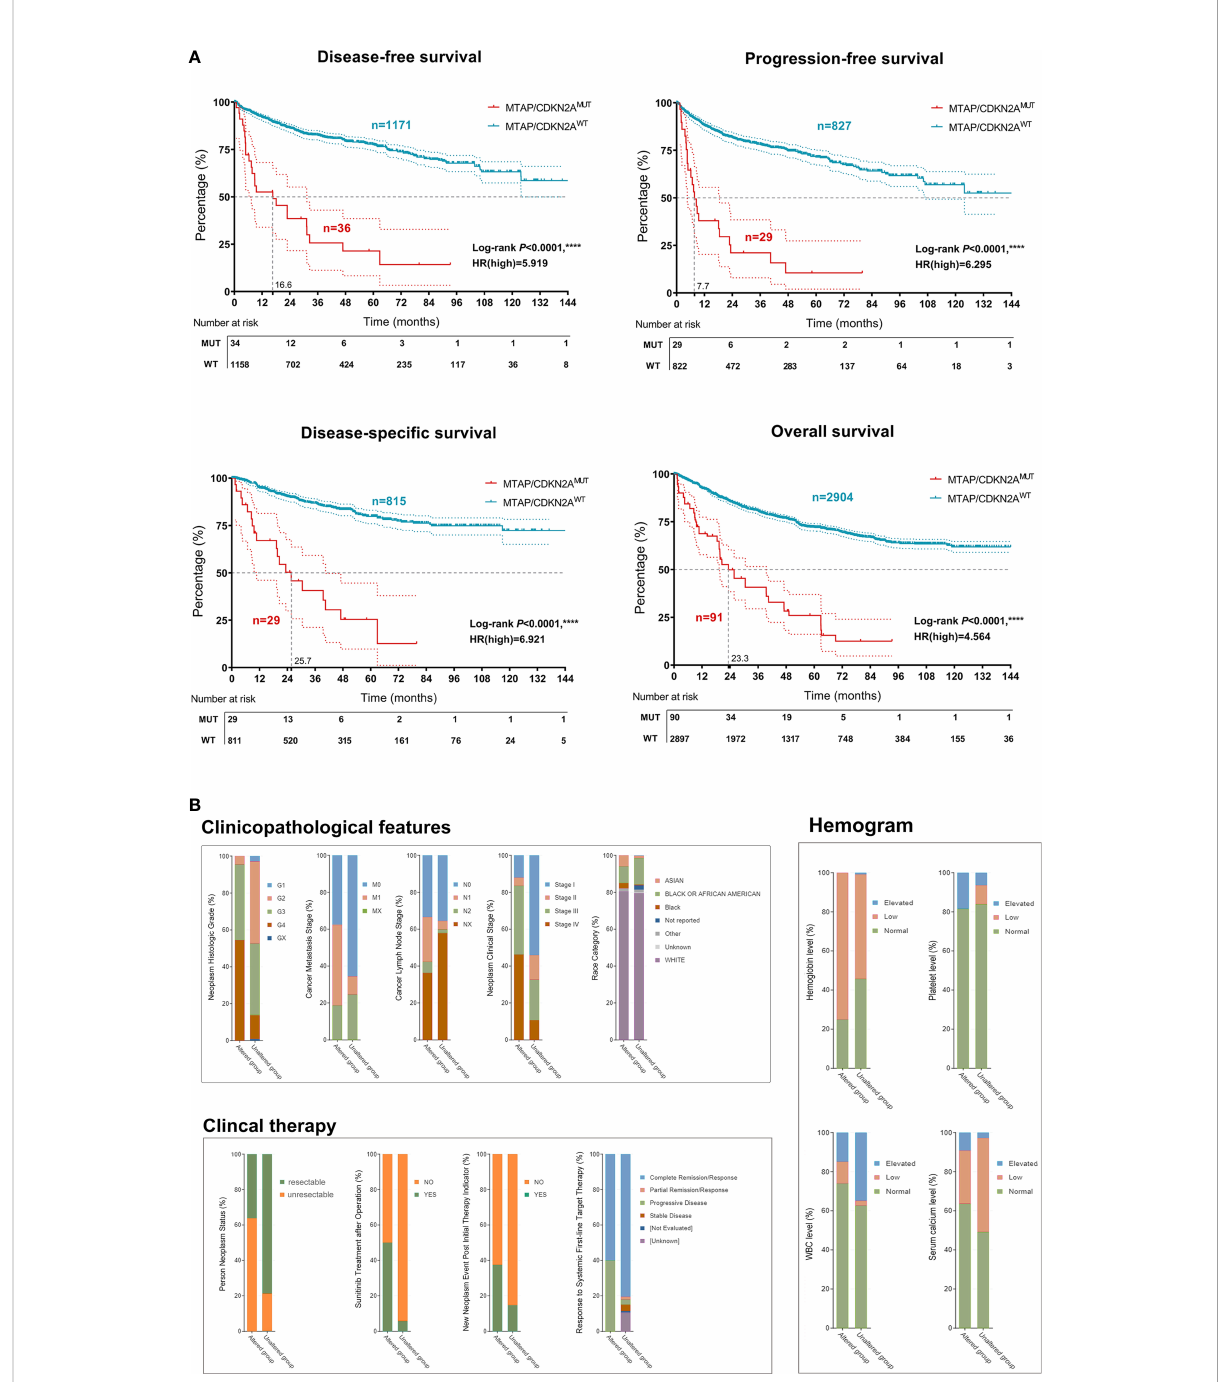
FIGURE 4 Implications of MTAP / CDKN2A MUT in prognosis, clinicopathological features, and sensitivity to therapy of 3,563 patients with RCC from the Western cohort. (A) Classi fi ed by the MTAP MUT , DSS, PFS, DFS, and OS of RCC patients from the Western cohort using Kaplan – Meier survival analysis and log-rank test. (B) Classi fi ed by the CDKN2A MUT , DSS, PFS, DFS, and OS of RCC patients from the Western cohort using Kaplan – Meier survival analysis and log-rank test. ****,